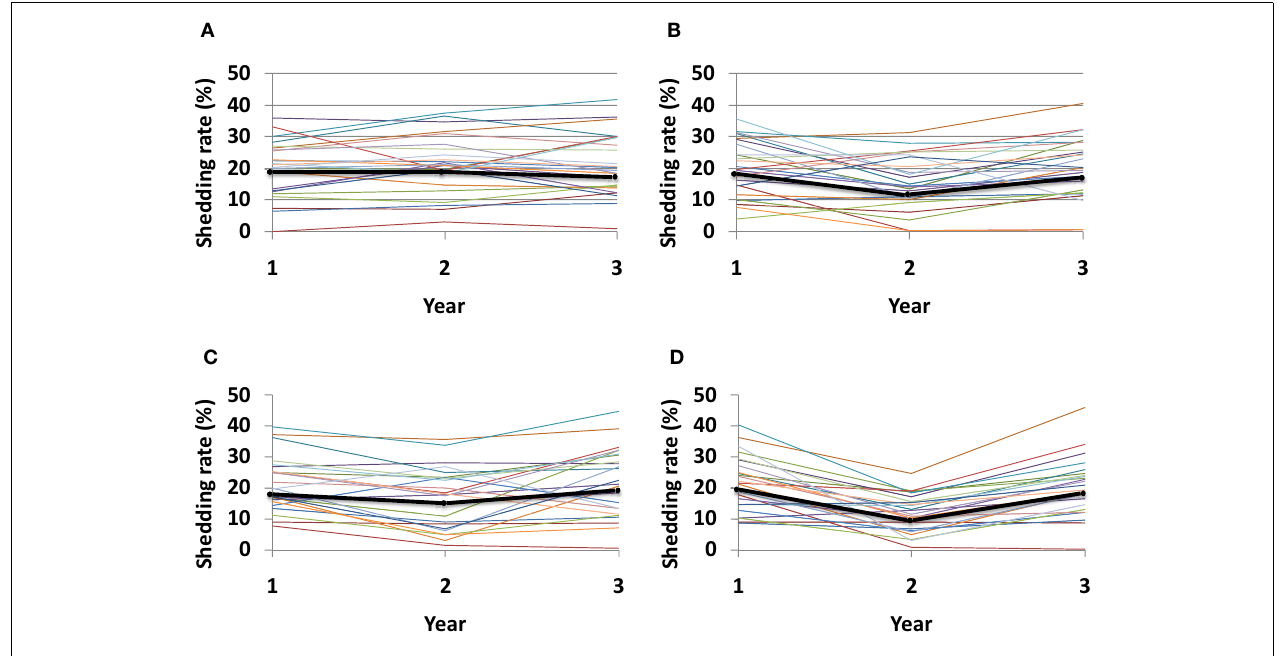
T-cells applied within each individual region, (B) 50% increase of total CD8 + T-cells applied within each individual region, (C) 25% increase of total CD8 + T-cells applied evenly across all 300-modeled regions, and (D) 50% increase of total CD8 + T-cells applied evenly across all 300-modeled regions. An increase in total number of recruited CD8 + T-cells (B,D) , as well as a more even recruitment of CD8 + T-cells (C,D) leads to the largest decline in shedding at year 2, though normal dynamics eventually return leading to high shedding during year